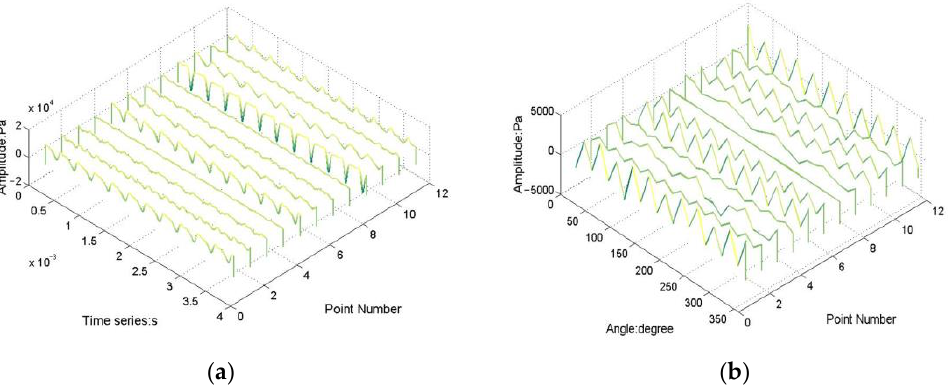
Figure 5. The ( a ) pressure time signals (one rotating period) at each monitoring point; ( b ) circum- ferential pressure distribution at each monitoring point (at one moment).